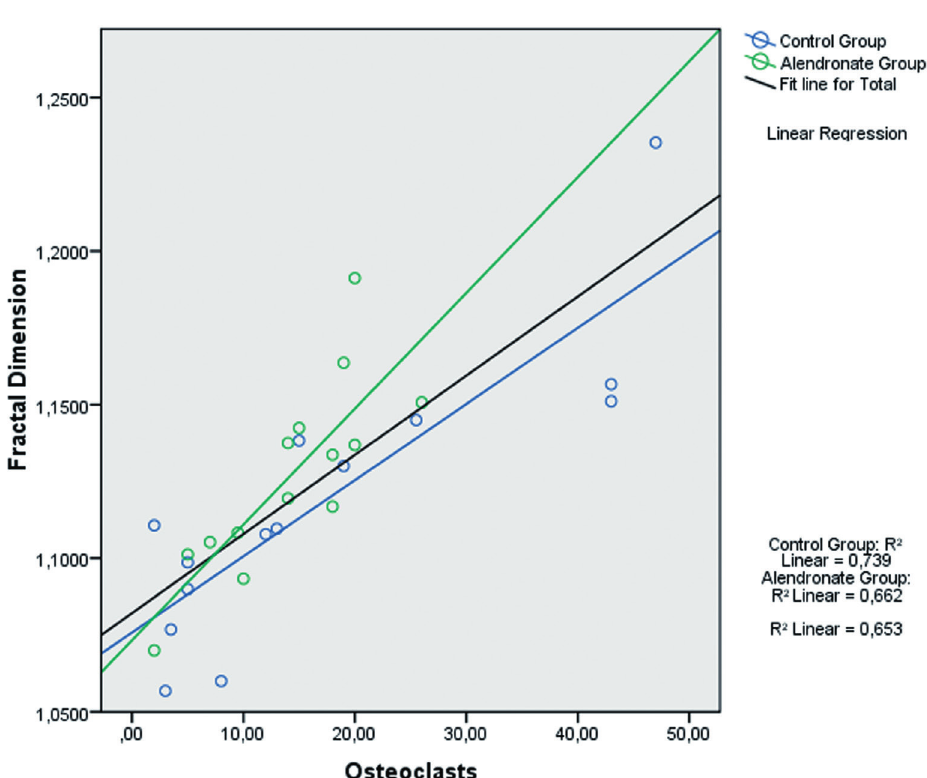
Figure 4- Scatterplot showing the correlation between fractal dimension and number of osteoclasts. Strong correlation was found for both control (r=0.86, p<0.01) and alendronate groups (r=0.813, p<0.01), as well as the entire sample (r=0.808, p<0.01). Note that with the increase in the number of osteoclasts, there was an increase in fractal dimension